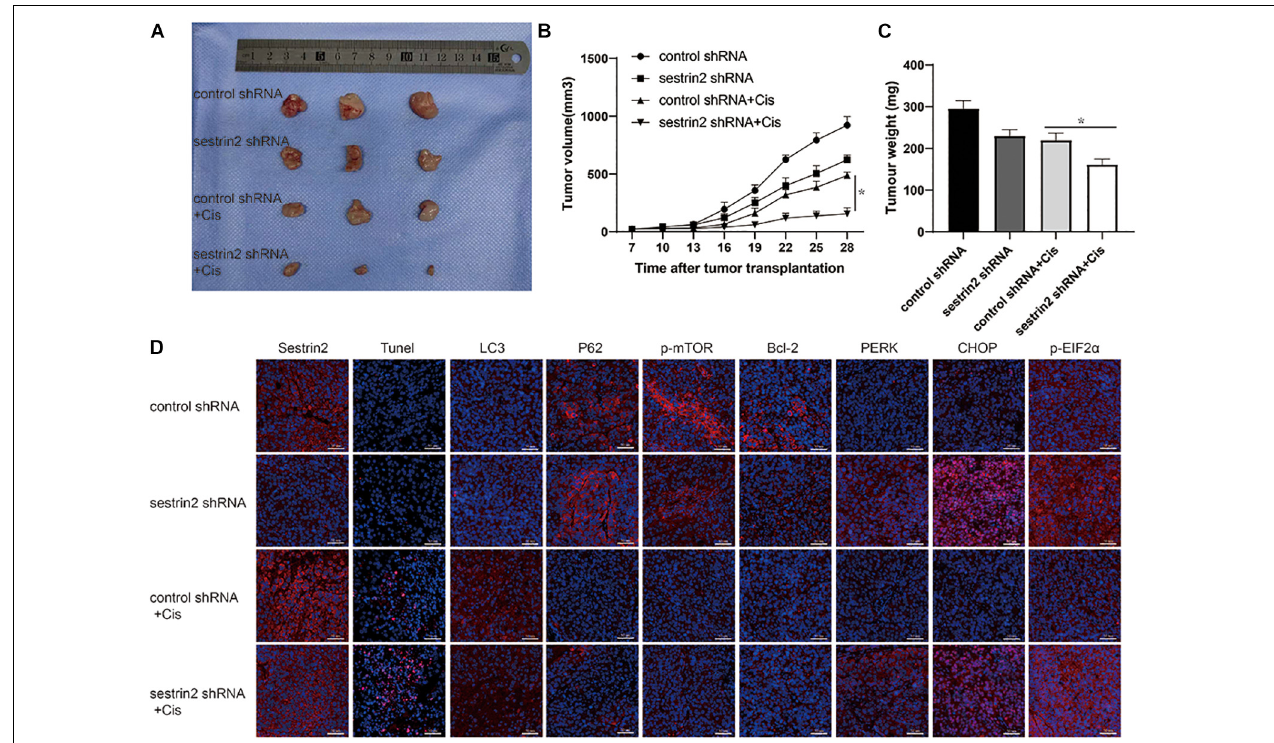
FIGURE 6 | Suppression of SESN2 increases sensitivity to chemotherapy in vivo . NU/NU nude mice were subcutaneously injected with SESN2-knockdown or control 143B cells. After 7 days, the mice were intraperitoneally injected with Cis (20 µ mol/L) until they were killed on day 28. Tumour volume was measured on day 28 (A) ( n = 3). Tumour growth curves were measured from days 7 to 28 (B) ( n = 3). Tumour weight was measured on day 28 (C) ( n = 3). Immunofluorescence staining of TUNEL, SESN2 expression, LC3 expression, P62 expression, p-mTOR expression, Bcl-2 expression, PERK expression, CHOP expression and p-eIF2 α expression after tumour sample injection (D) ( n = 3, scale bar = 50 µ m). The data are presented as the mean ± SD. * p < 0.05 vs. the Control shRNA + Cis